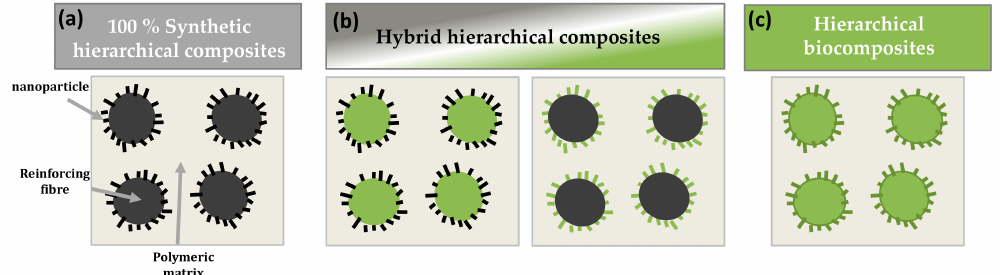
Figure 4. Schematic structures of the different hierarchically nanostructured fibre reinforced composites with: ( a ) fully synthetic hierarchical composites, ( b ) hybrid hierarchical composites either reinforced with bio-based nanoparticle modified synthetic fibres or with synthetic or mineral nanoparticle modified natural fibres; and ( c ) hierarchical biocomposites reinforced with bio-based nanoparticle modified natural fibres. Green colour stands for bio-based (nano-)reinforcements and black colour stands for synthetic